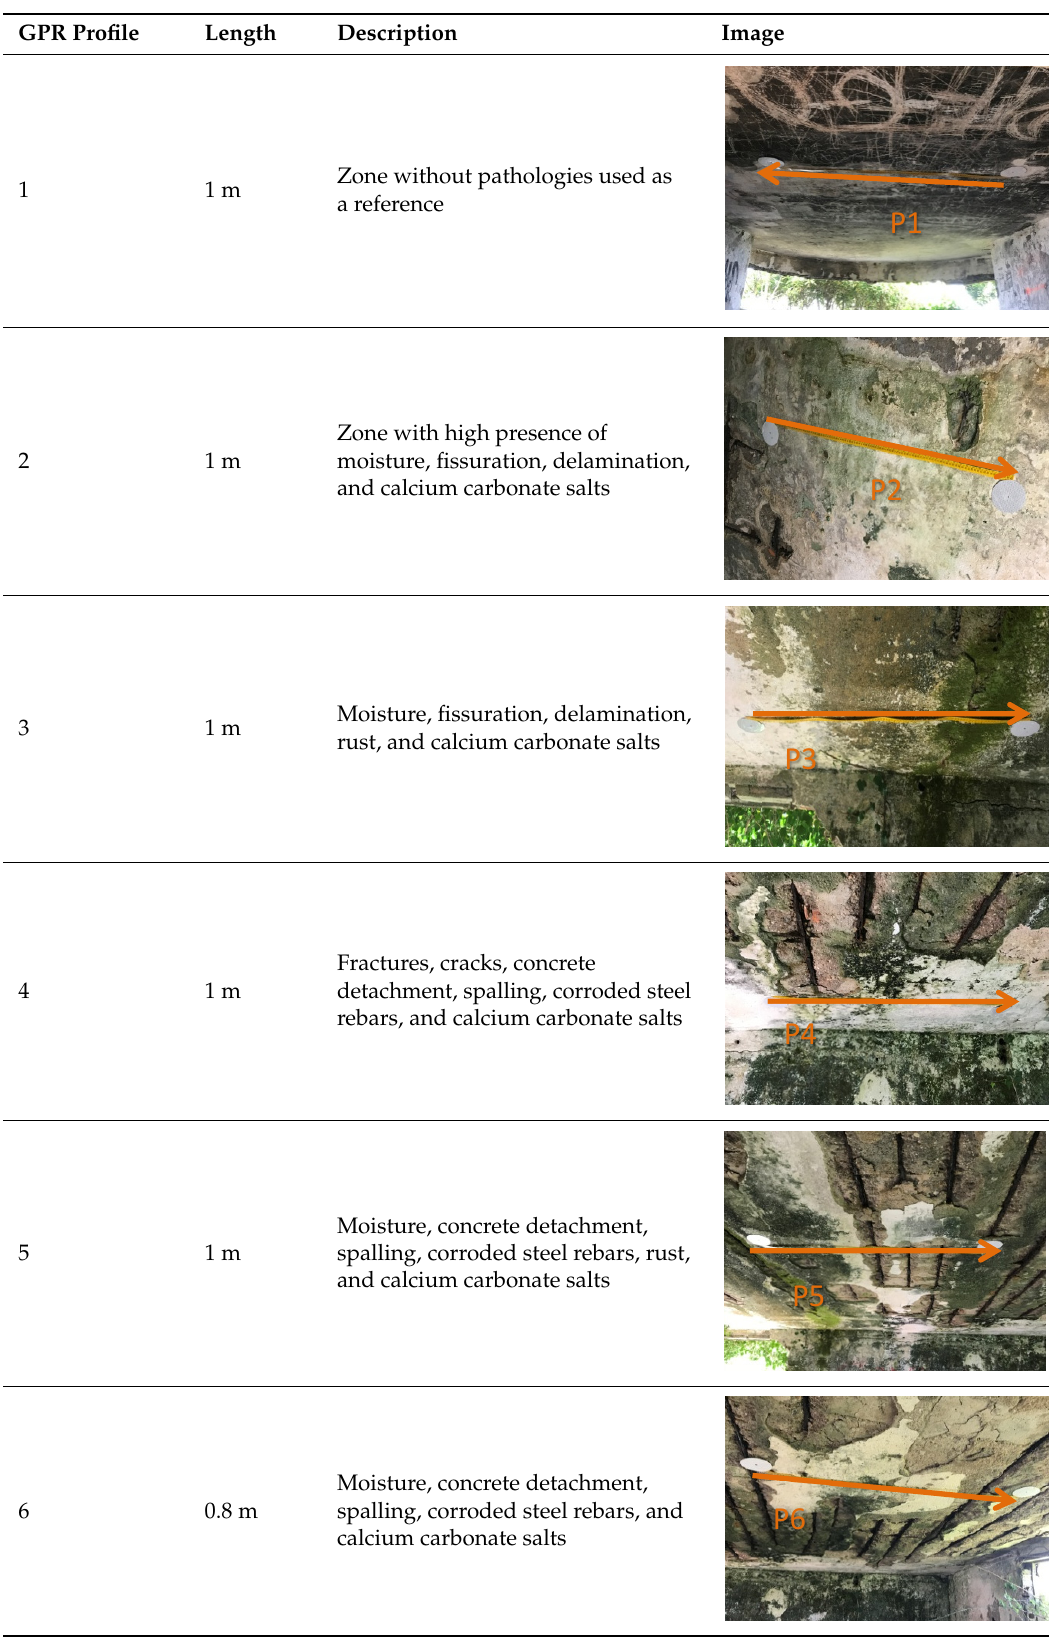
Table 2. Filters used for GPR data processing.